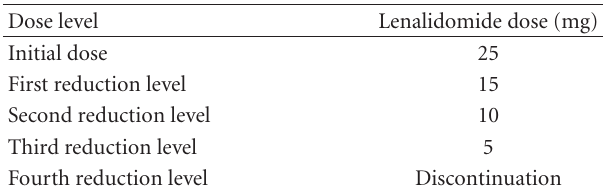
Table 2: Lenalidomide dose reduction levels with adequate renal